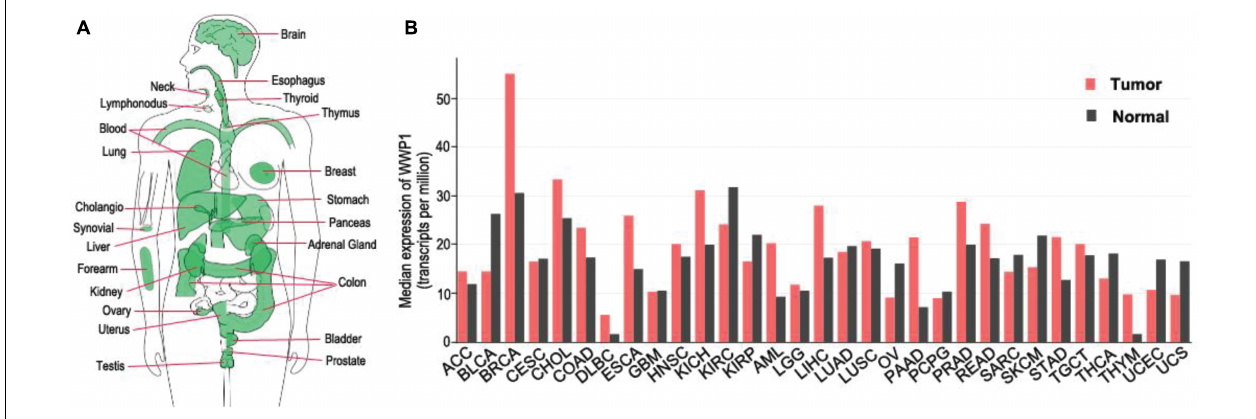
FIGURE 1 | Expression of WWP1 in human body and tumor tissues. (A) WWP1 expression of normal samples in bodymap. All organs expressing WWP1 mRNA are painted green. WWP1 expression is analyzed in website http://gepia.cancer-pku.cn/. (B) The gene expression profile across all tumor samples and paired normal tissues according to the analysis in website http://gepia.cancer-pku.cn/. TPM, transcripts per million; ACC, Adrenocortical carcinoma; BLCA, Bladder Urothelial Carcinoma; BRCA, Breast invasive carcinoma; CESC, Cervical squamous cell carcinoma and endocervical adenocarcinoma; CHOL, Cholangio carcinoma; COAD, Colon adenocarcinoma; DLBC, Lymphoid Neoplasm Diffuse Large B-cell Lymphoma; ESCA, Esophageal carcinoma; GBM, Glioblastoma multiforme; HNSC, Head and Neck squamous cell carcinoma; KICH, Kidney Chromophobe; KIRC, Kidney renal clear cell carcinoma; KIRP, Kidney renal papillary cell carcinoma; AML, Acute Myeloid Leukemia; LGG, Brain Lower Grade Glioma; LIHC, Liver hepatocellular carcinoma; LUAD, Lung adenocarcinoma; LUSC, Lung squamous cell carcinoma; MESO, Mesothelioma; OV, Ovarian serous cystadenocarcinoma; PAAD, Pancreatic adenocarcinoma; PCPG, Pheochromocytoma and Paraganglioma;